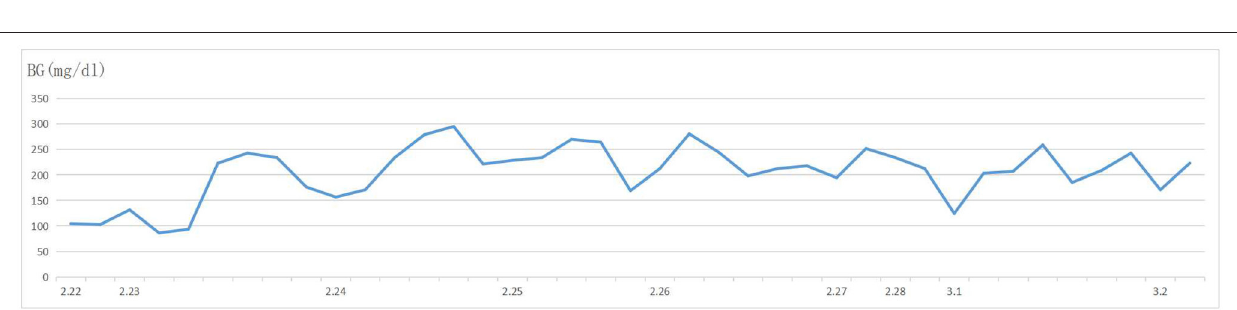
FIGURE 2 | Blood glucose levels of the patient after resection of the pancreatic carcinoma. The level of blood glucose consistently remained between 86 and 295 mg/dl after resection of the pancreatic